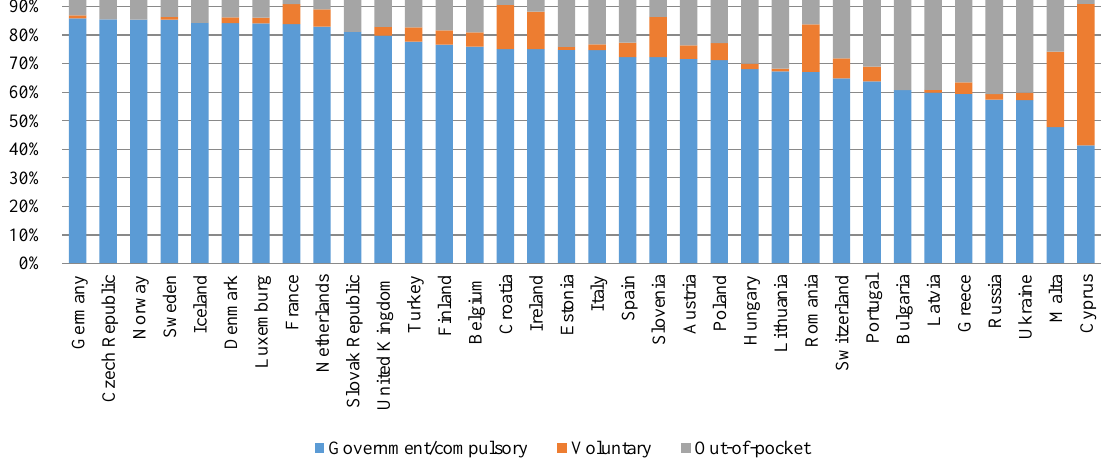
Fig. 4. Structure of health spending by sources in 2019